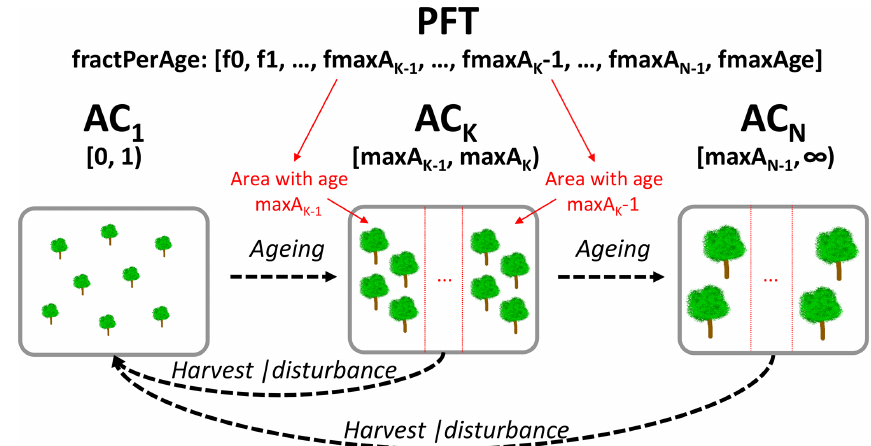
Figure 3. Visualisation of forest age-class (AC) boundaries, the fractPerAge vector, and processes causing shifts from one AC to another in JSBACH–FF. Each AC covers a certain interval of ages. The first AC contains all forest younger than 1 year; an arbitrary AC K covers [maxA K − 1 , maxA K ), i.e. the ages in the right-open interval of the upper age boundary of the previous AC (maxA K − 1 ) and its own upper age boundary (maxA K ); finally the last class AC N covers all forest older than and including the upper age boundary of the next younger class (maxA N − 1 ), with maxA N − 1 being smaller or equal to the total maximum age (maxAge). The information on the area covered by the different ages (indicated in red) is tracked in the fractPerAge vector of the associated forest PFT. Three processes can lead to the movement of area fractions among ACs: ageing leads to the movement of the fraction exceeding the maximum age of an AC; harvest and disturbances lead to the movement of fractions to the first